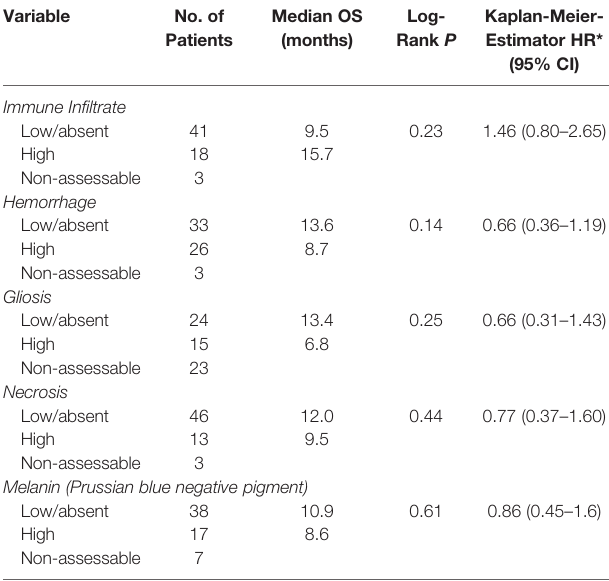
TABLE 2 | Histopathologic factors in relation to overall survival (OS) in patients with melanoma brain metastases from the UNC-CH craniotomy cohort.